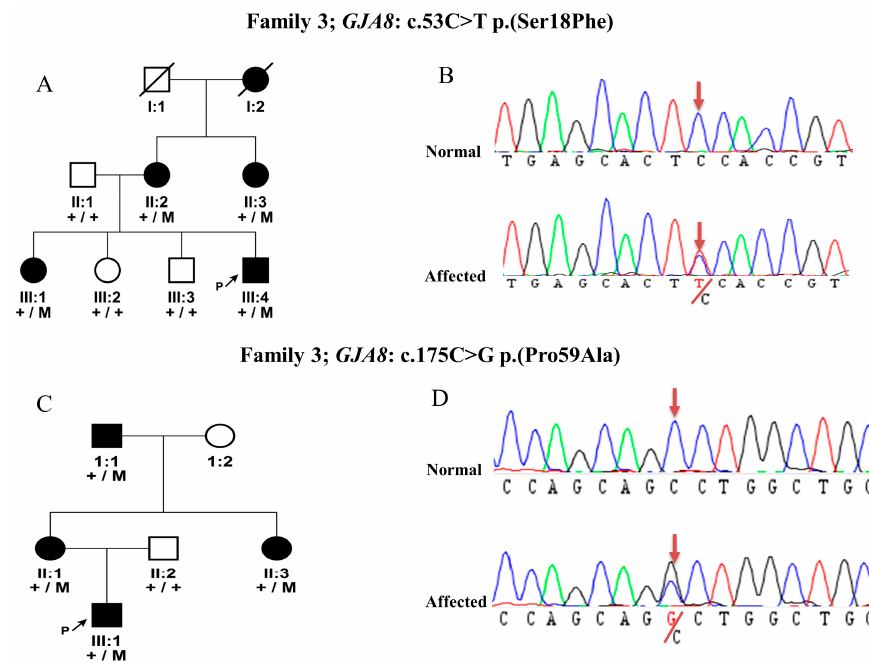
Figure 3. Pedigrees of two families with GJA8 mutations: ( A ) pedigree of Family 3 with congenital cataract, and segregation of a novel mutation c.53C>T p.(Ser18Phe) in the GJA8 gene; ( B ) DNA sequence chromatogram of c.53C>T p.(Ser18Phe) mutation; ( C ) Family 4 segregation of a mutation c.175C>G p.(Pro59Ala) in the GJA8 gene; and ( D ) DNA sequence chromatogram of c.175C>G p.(Pro59Ala) mutation in GJA8.